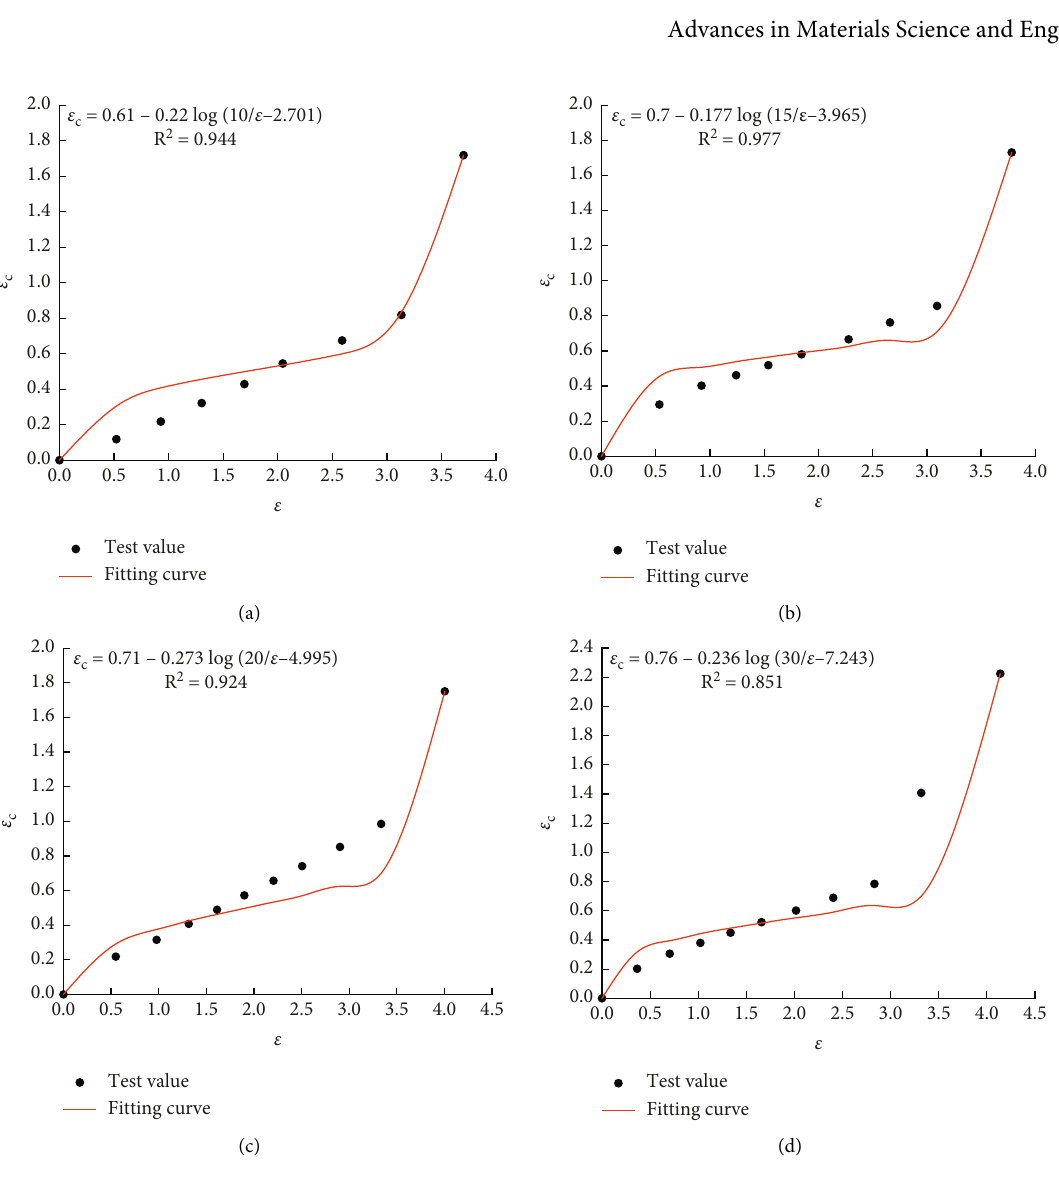
Figure 7: Trend of plastic strain under different confining